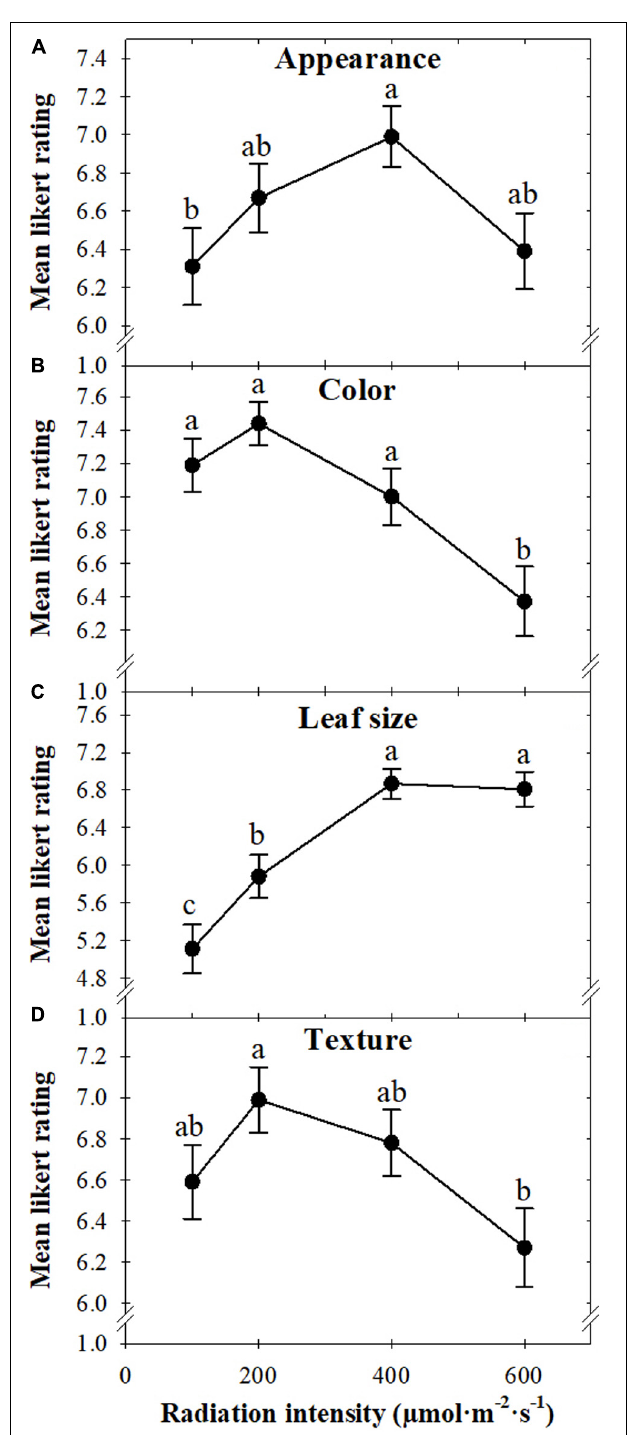
FIGURE 6 | The mean appearance (A) , color (B) , leaf size (C) , and texture (D) of sweet basil “Nufar” ( Ocimum basilicum ) grown under 100, 200, 400, or 600 µ mol · m − 2 · s − 1 photosynthetic photon flux density (PPFD), based on a nine-point Likert scale ranging from dislike extremely (1) to like extremely (9). Means not followed by the same letter are significantly different by Tukey honestly significant difference test ( P < 0.05). Each symbol represents 90 responses ±